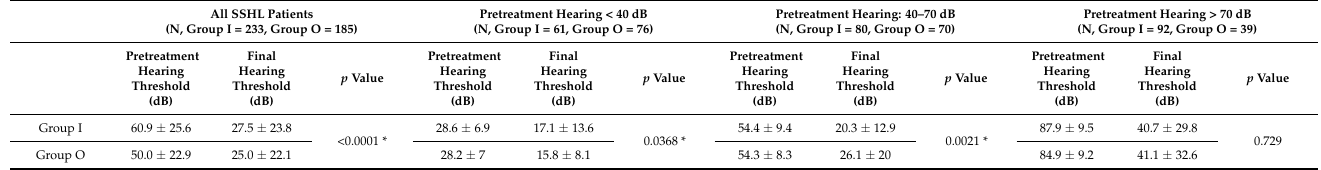
Table 3. Comparison of pretreatment and final hearing threshold according to pretreatment sub- groups and